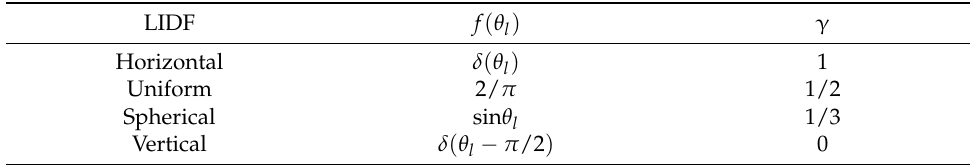
Table 1. Values of γ for some common LIDF types.